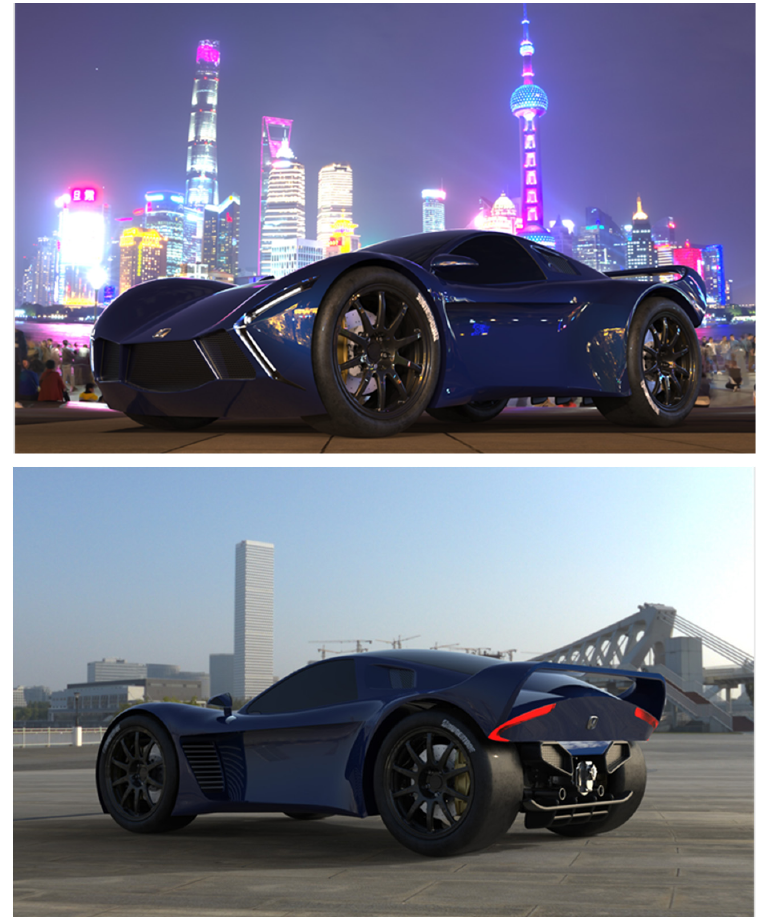
Figure 35. Stone concept rendering.